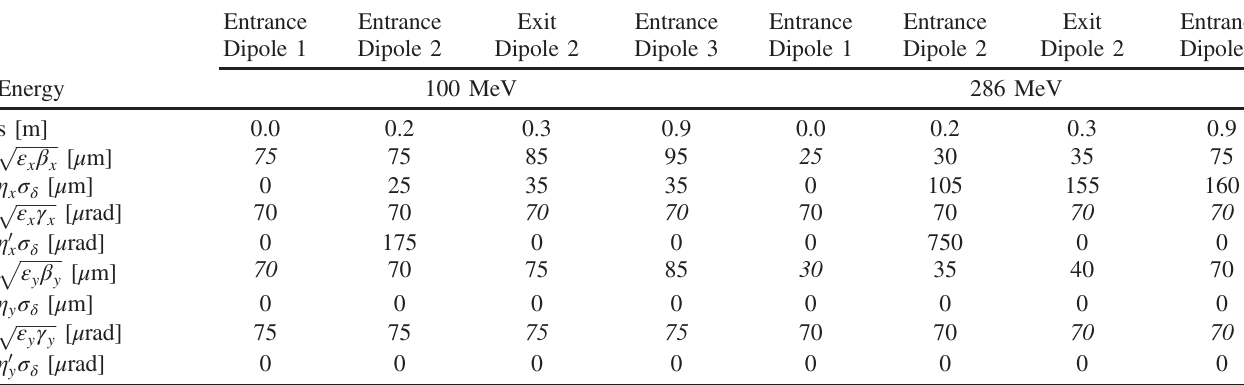
TABLE III. Beam rms size (in μ m) and angular divergence (in μ rad) across NIEM at 100 and 286 MeV. Top: horizontal (magnetic bending) plane; bottom: vertical plane. Longitudinal coordinate s refers to Fig. 6 for 100 MeVand to Fig. 7 for 286 MeV. Quantities in italics will be